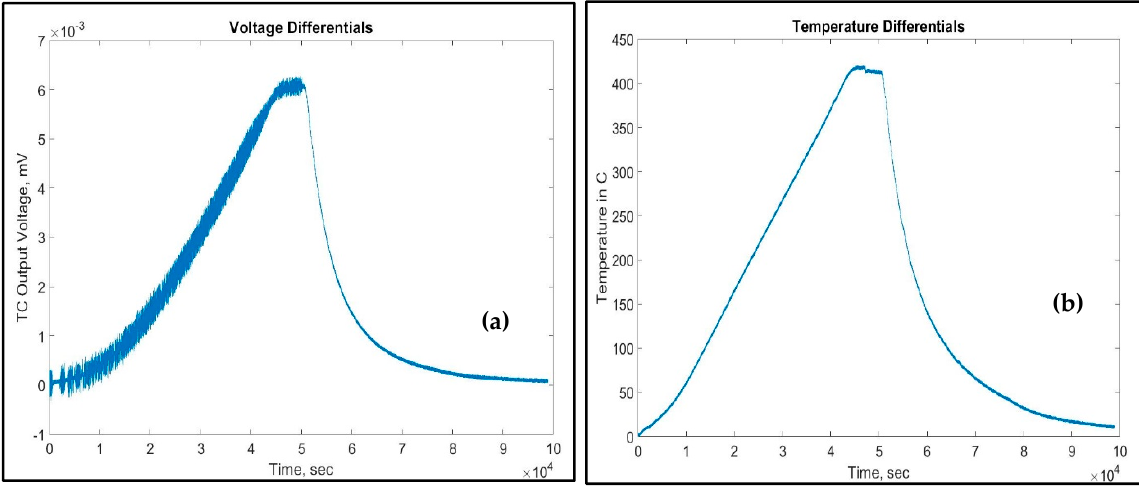
Figure 4. Voltage-temperature plots for ( a ) PG-Al, ( b ) PG-Cu, ( c ) PG-Steel, and ( d ) PG-W TCs obtained from experimental data upon cooling from 500 °C to room temperature.